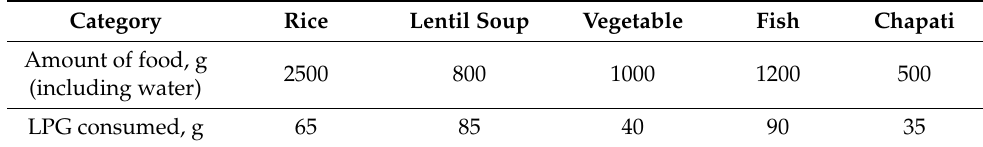
Table 6. Cooking energy data from LPG burner.